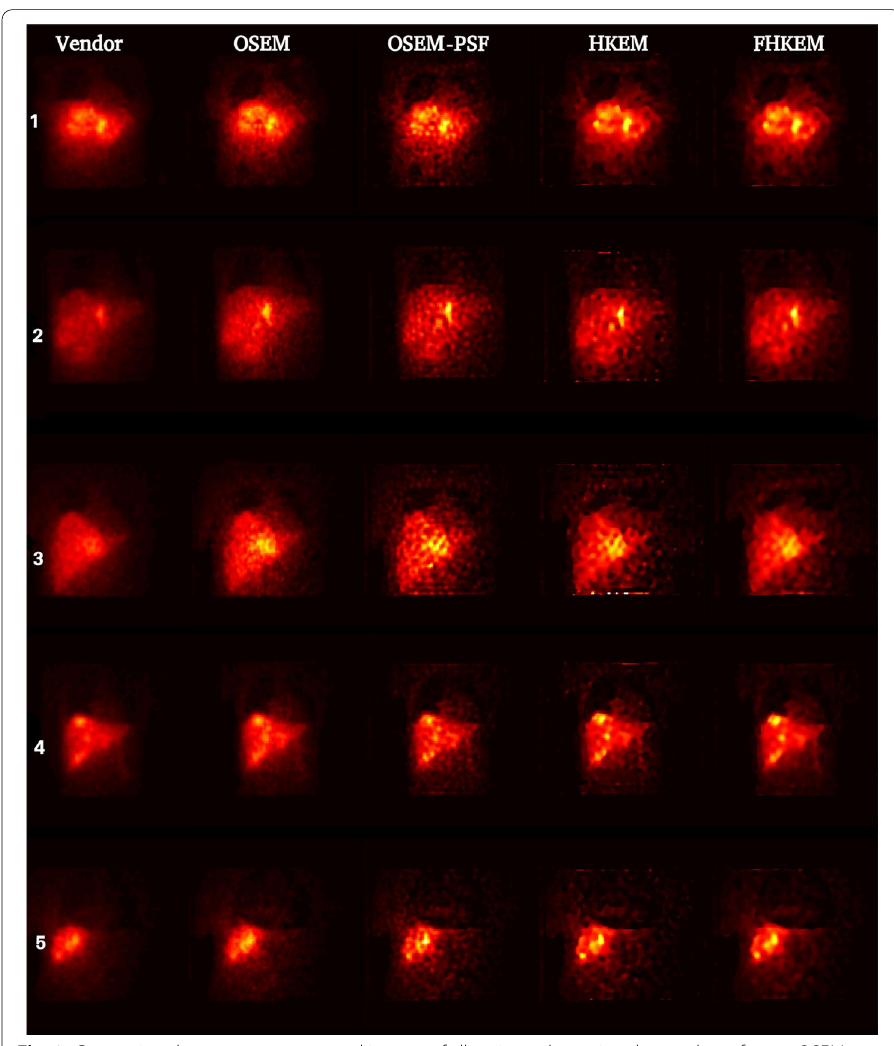
Fig. 9 Comparison between reconstructed images of all patients data using the vendor software, OSEM, OSEM‑PSF, HKEM and FHKEM with functional kernel frozen at the 72nd sub‑iteration. All images use the same